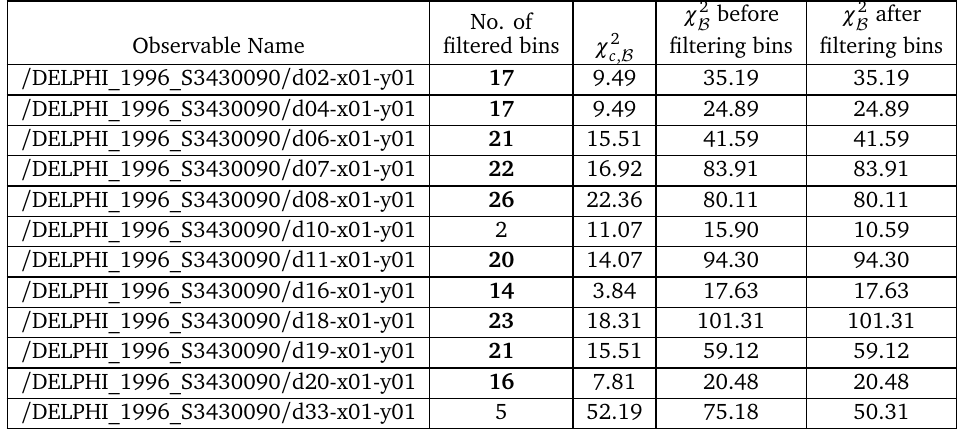
Table 20: Bin filtering of S HERPA data: Shown are the observables from which bins were removed and the number of bins removed. We also show the critical χ 2 values and the χ 2 test statistic before and after bin filtering. If all the bins were removed from the observable then the number of bins removed is shown in bold font and the χ 2 test statistic before and after bin filtering is the